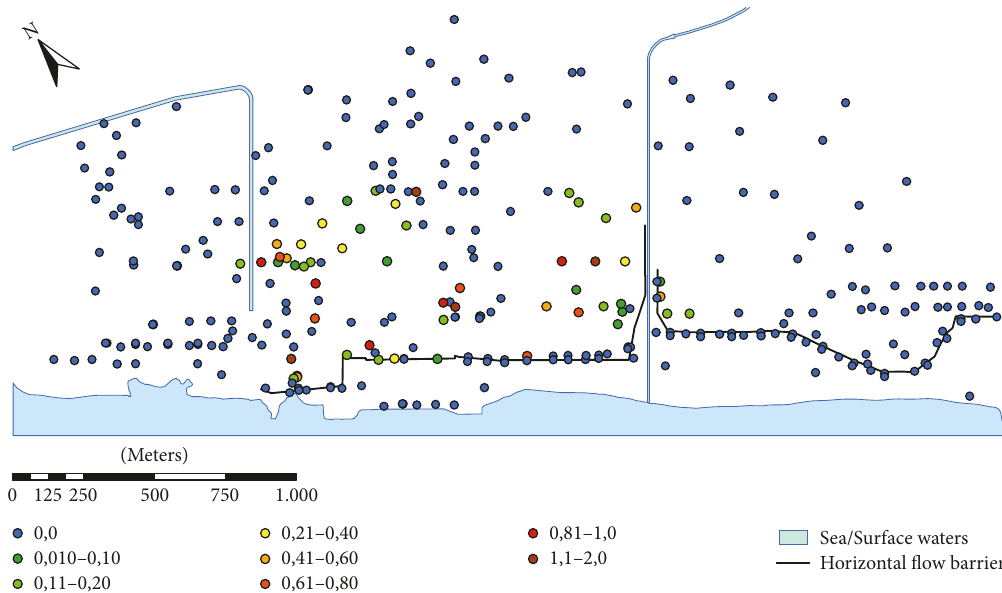
Figure 3: Distribution map of free LNAPL thickness (m) measured in the monitoring wells at June 2013.